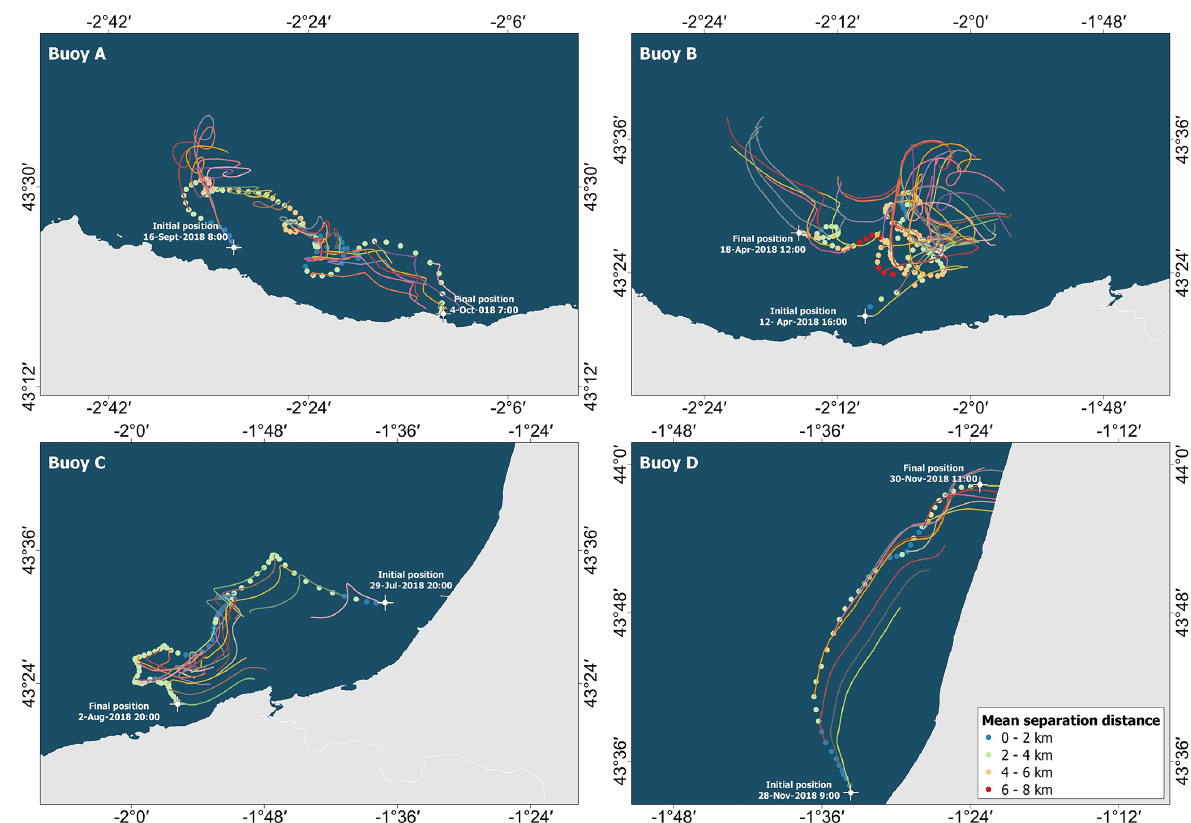
Figure 6. Spatial mean distance between modelled and observed trajectories of buoy A, B, C, and D with a drag coefficient C d = 4%. Particle trajectories were simulated during 24h, with a re-initialization period every 4h. The modelled trajectories are shown in solid lines. Circles represent the mean separation distance at the observed position for all the modelled